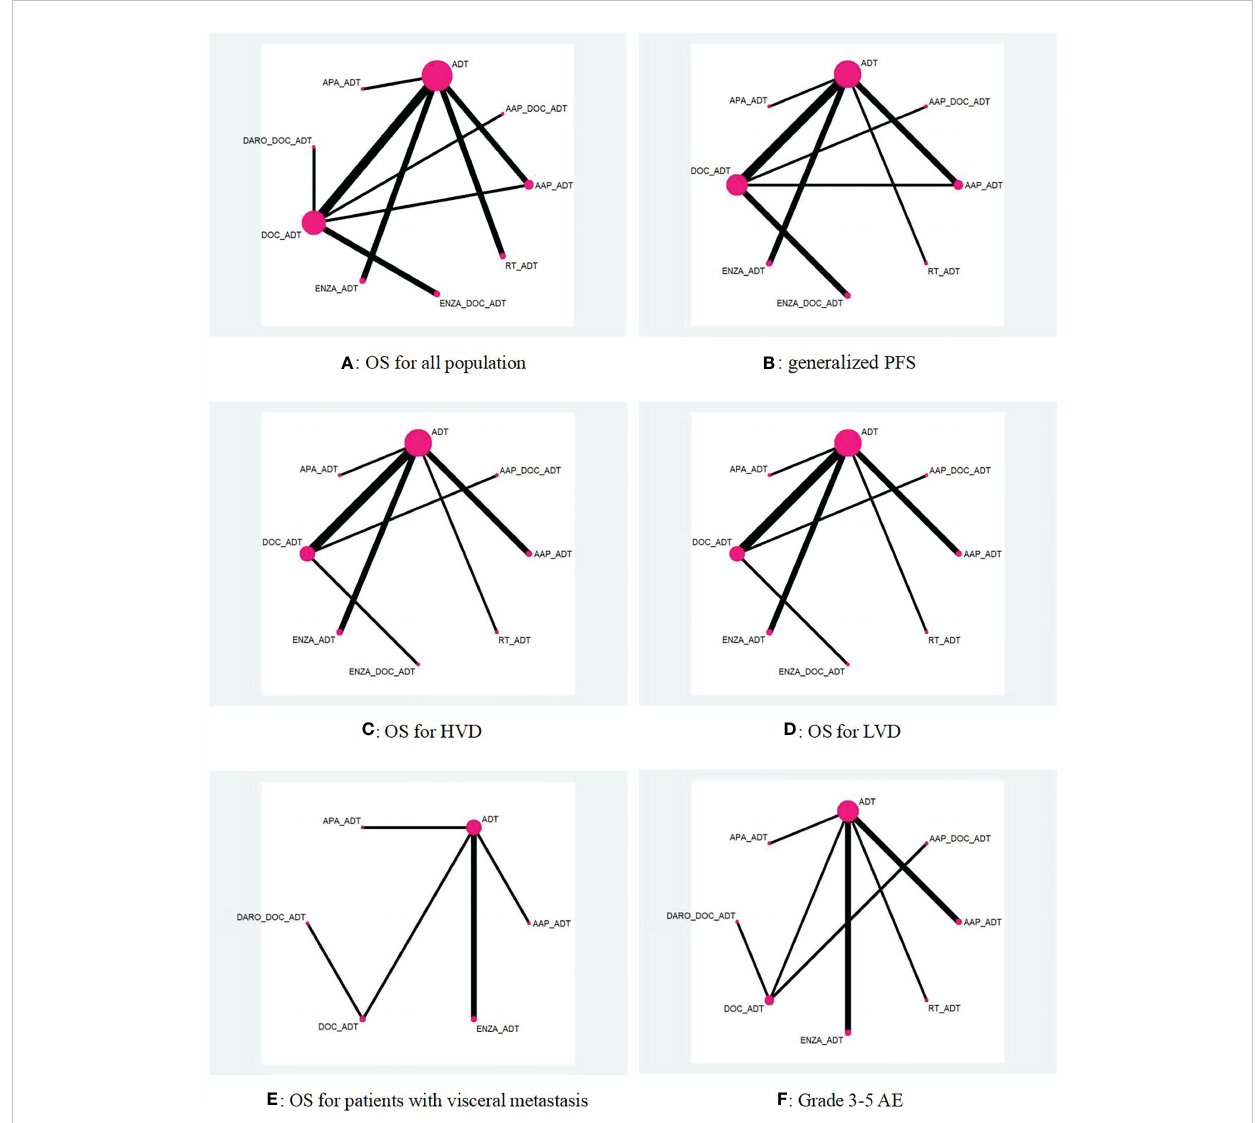
FIGURE 2 Network diagram of different treatment options for mHSPC (A – F) . AAP, abiraterone acetate and prednisone; ADT, androgen deprivation treatment; APA, apalutamide; DARO, darolutamide; DOC, docetaxel; ENZA, enzalutamide; HVD, high volume disease; LVD, low volume disease; OS, overall survival; PFS, progression free survival; RT, radiotherapy; The connector line “ _ ” represents combination of different treatment